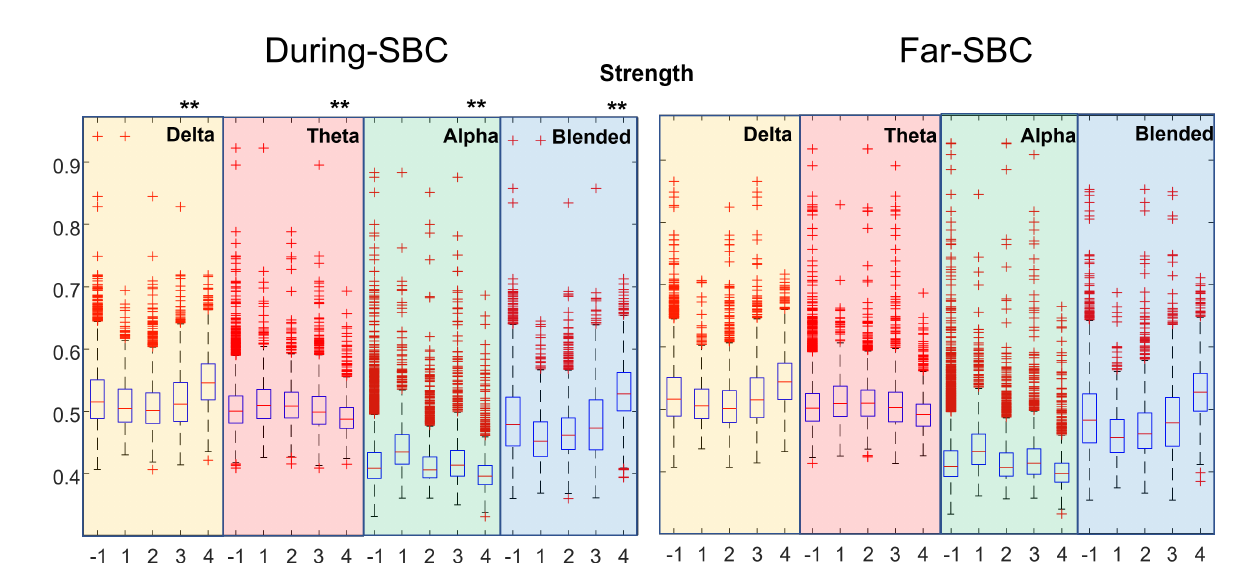
Figure 2. Distribution of strength index estimated in During–SBC and Far–SBC conditions, for various rhythms and EEG traces showing different pathological conditions. Each box and whiskers plot shows the distribution of a set of recordings of different patients with a specific severity condition reported in the x -axis ( − 1 indicates all the recordings grouped, independently from the patients clinical condition). Different background colors represent different frequency ranges: yellow for delta rhythm, red for theta, green for alpha and blue for the delta–theta blended frequency range. Double asterisks (**) highlight strong statistical differences ( p < 0.01) between the During-SBC and the correspondent Far–SBC distributions (paired comparisons) for each frequency band, considering all the subjects’ recordings together.